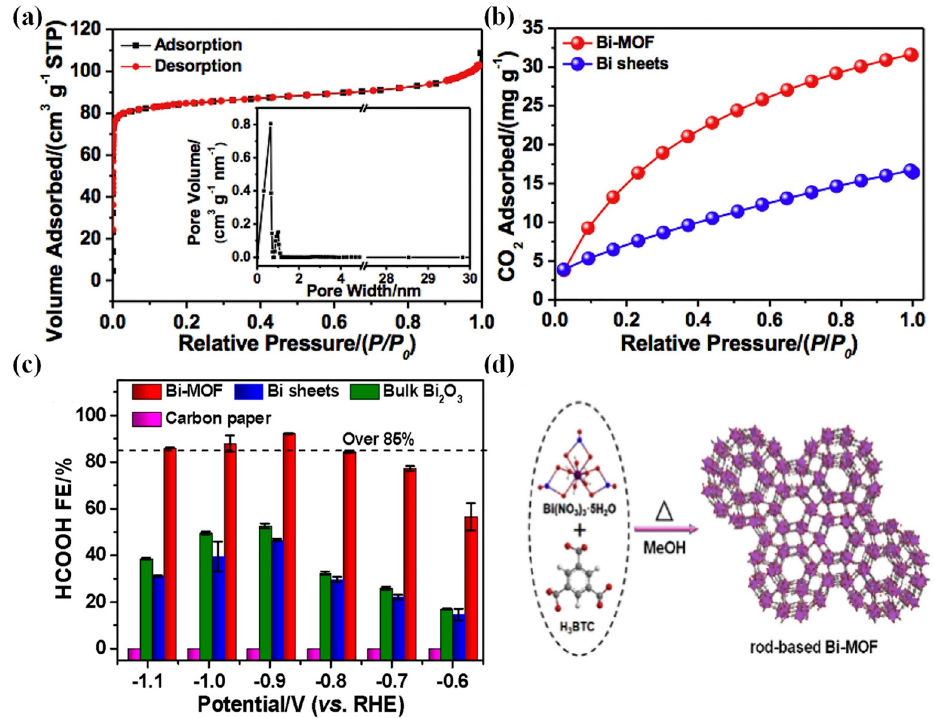
Figure 5. ( a ) N 2 adsorption / desorption curves of Bi − MOF; ( b ) CO 2 adsorption curves of Bi-MOF and Bi sheets; ( c ) Faraday efficiency of HCOOH; ( d ) structure of Bi-MOF [57]. Reprinted with permission from Ref. [57]. Copyright 2020 Copyright Elsevier (Amsterdam, The Netherlands).